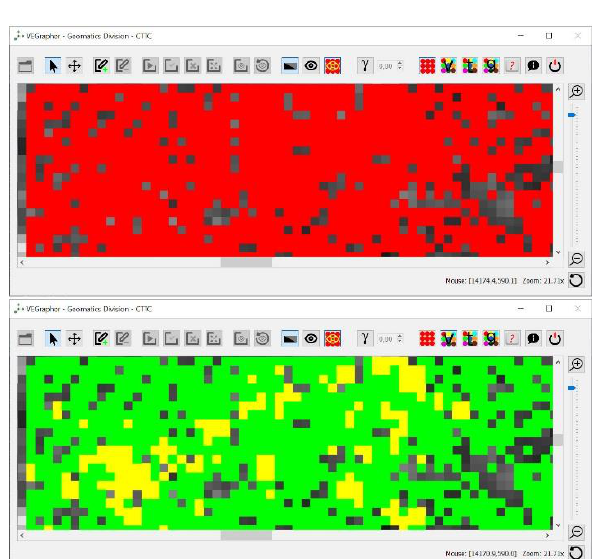
Figure 2: Points shown using the default colouring schema (up, red) and displayed with a velocity colour table (down, green &